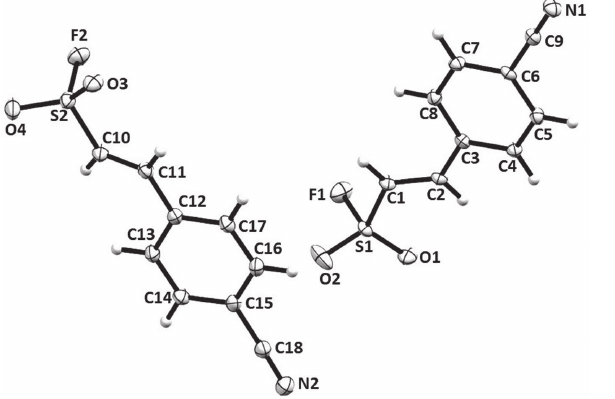
Table 1: Data collection and